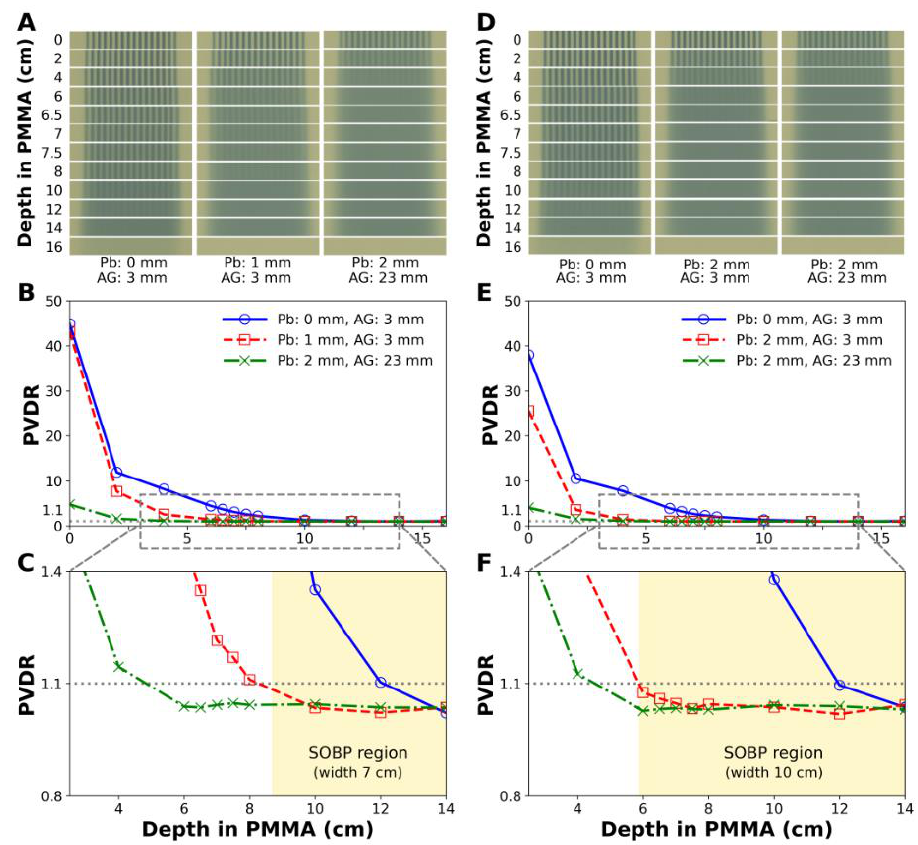
Figure 5. Dose distributions and PVDR measured by EBT3 films for proton minibeam with nominal energy of 163.3 MeV generated by a diverging MSC and a scattering device. ( A – C ) are for a 7 cm SOBP beam, and ( D – F ) are for a 10 cm SOBP beam. ( C , F ) are the magnified images of ( B , E ), respectively. The shaded areas indicate the SOBP regions. Pb: lead sheet, AG: air gap.